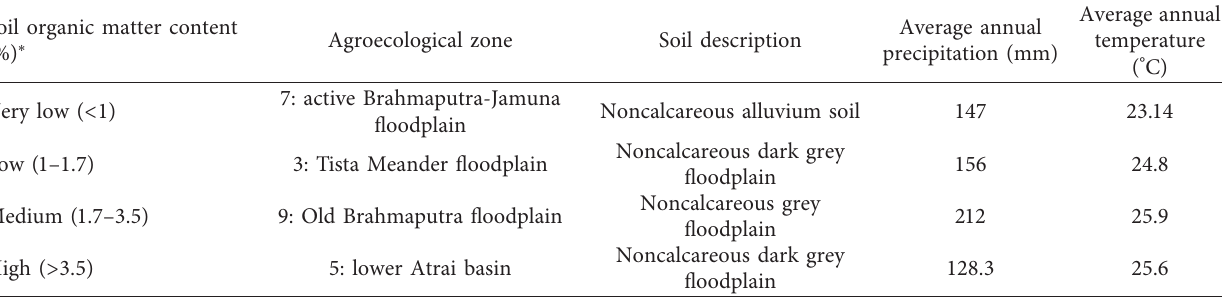
Table 1: Climatic and soil data of the selected